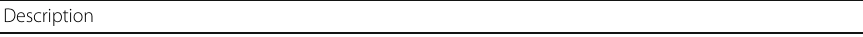
Table 3 Image-defined risk factors in Neuroblastoma [8] Anatomic